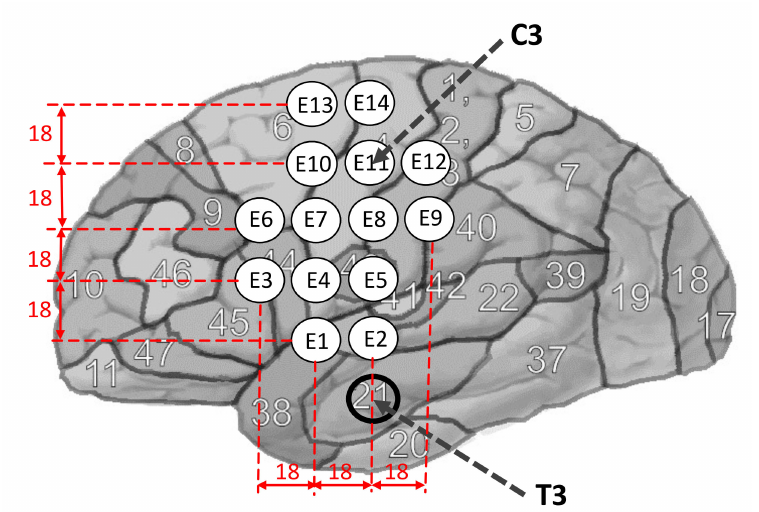
Figure 1. Location of the neuroheadset, which contains 14 electrodes (E1, . . . ,E14) covering a section of the left hemisphere (language area). This is, the sensorimotor interface area and articulatory network of Hickok and Poeppel (Broca’s area and motor cortex) related to Brodmann areas: 4, 6, 43, 44 and 45. C3 and T3 are reference points from the 10–20 positioning